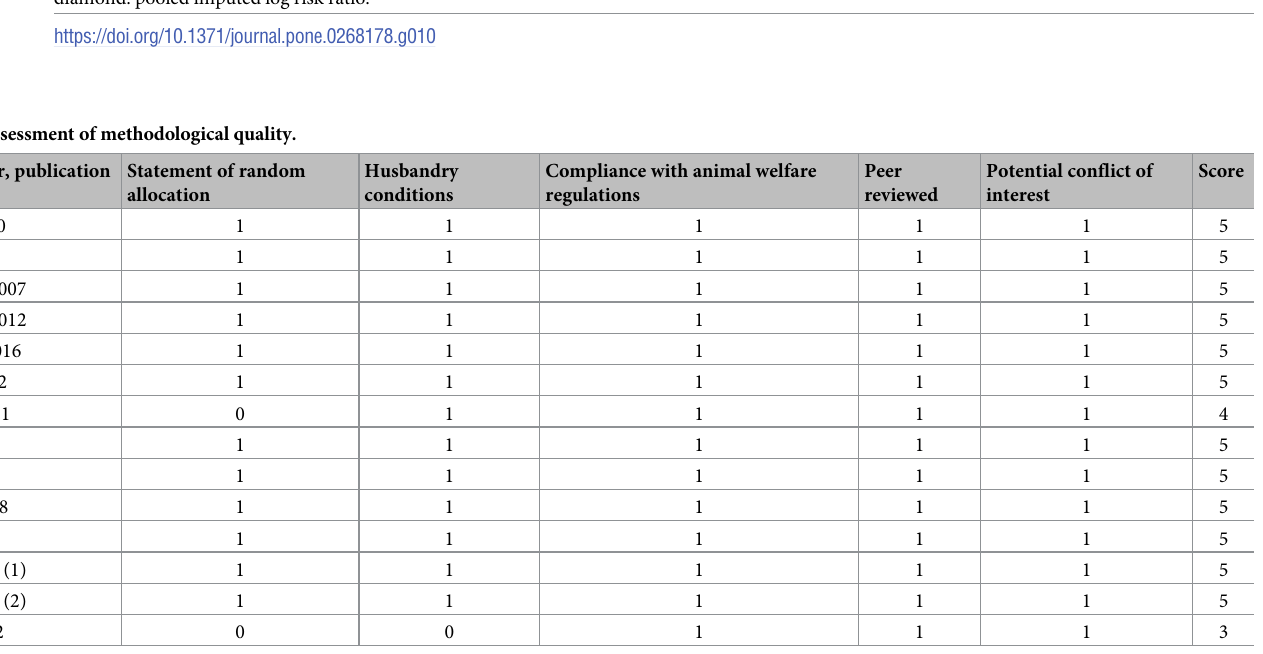
Fig 10. Funnel plot of comparison: Methylene blue compared with saline used as control; outcome—macroscopic adhesion score. White circles: included comparisons. Black circles: imputed comparisons using the trim-and-fill method. White diamond: pooled observed log risk ratio. Black diamond: pooled imputed log risk ratio.